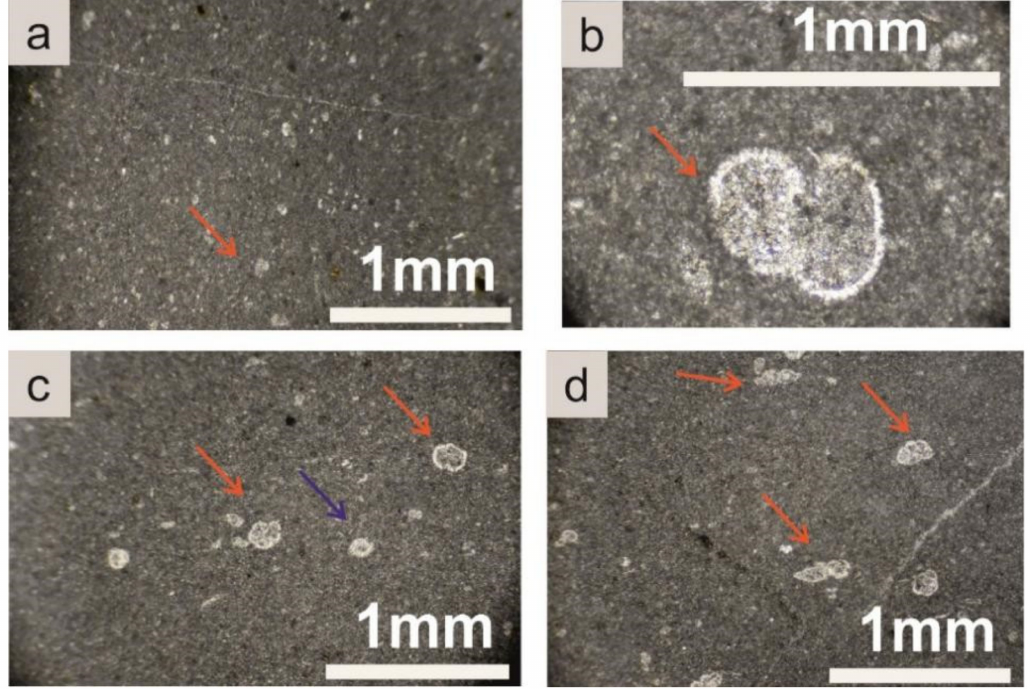
Figure 11. Microfacies typeF3: Mudstone/wackestone with planktic foraminifera (red arrow) of Paleocene age. ( a ) mudstone with planktic foraminifera (red arrow), sample KM11, ( b ) mudstone with planktic foraminifera (red arrow), sample KM11, ( c ) mudstone with planktic foraminifera (red arrow) and radiolaria (purple arrow), sample KM6, ( d ) Mudstone with planktic foraminifera (red arrow), sample